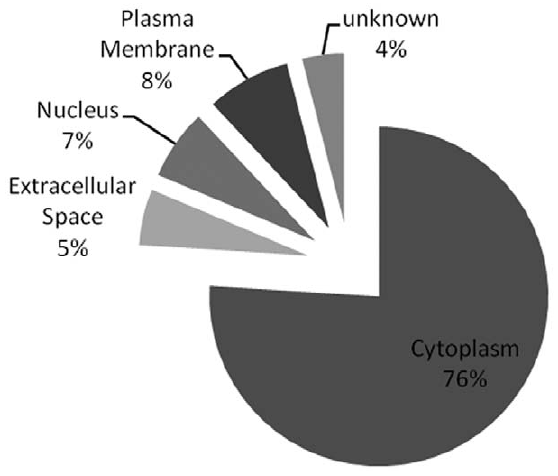
Figure 7. GO-Compartments. The 75 unique proteins (ANOVA # 0.05) were categorized according to the subcellular compartment (extracellular space, plasma membrane, cytoplasm, nucleus, and unknown). Information was collected from Gene ontology by IPA. Percentages are presented.